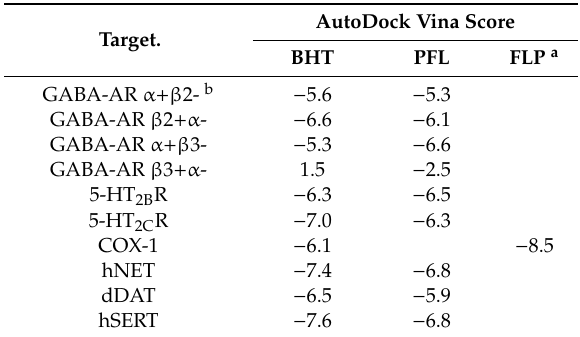
Table 2. AutoDock Vina scores obtained by docking simulations.